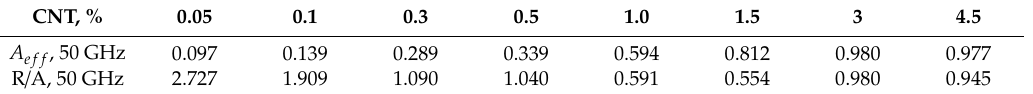
Table 1. Index A e ff and reflection / absorption indexes ratio R / A of CNT / PE